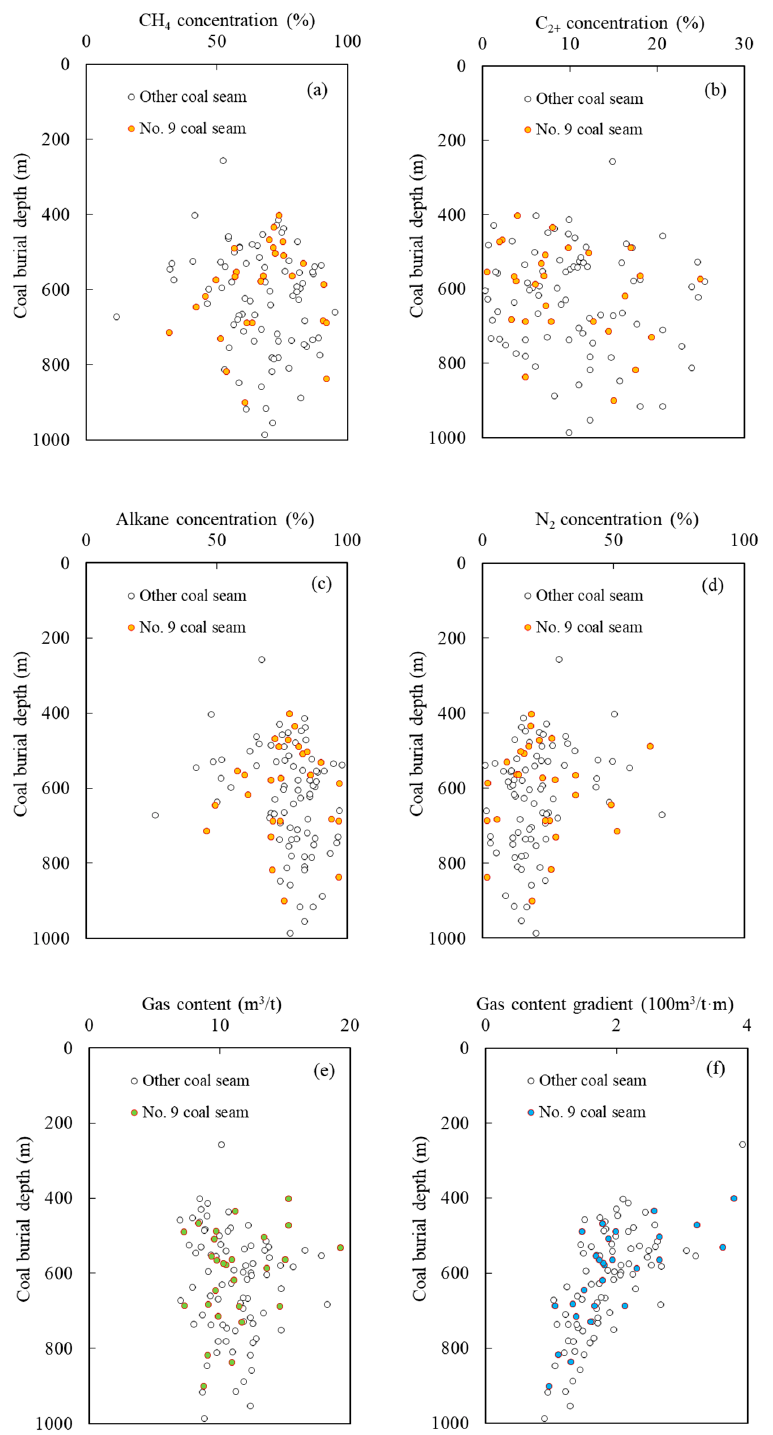
Figure 4. The gas-bearing property parameters vary with the coal burial depth. ( a ) methane concentration, ( b ) heavy hydrocarbon gas concentration, ( c ) alkane concentration, ( d ) N 2 concentration, ( e ) gas content, and ( f ) gas content gradient.